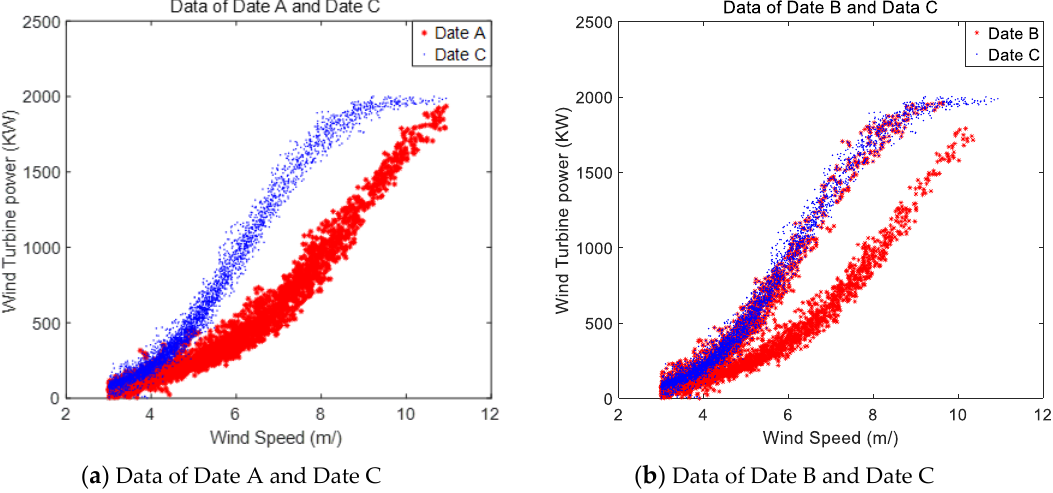
Figure 7. Comparative analysis of Dates A, B and C. Appl. Sci. 2020 , 10 , x FOR PEER REVIEW